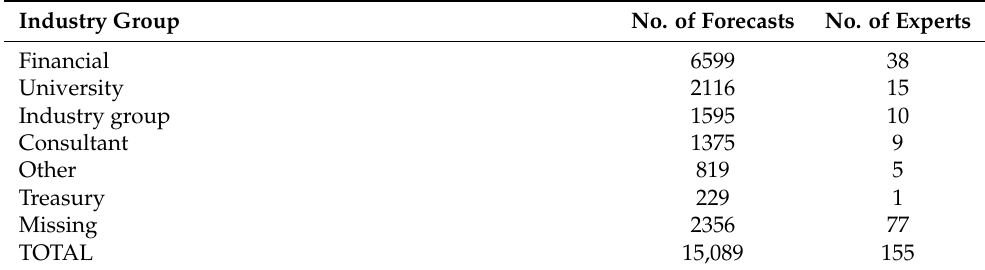
Table 3. The number of experts with different affiliations and the number of forecasts they contributed in these